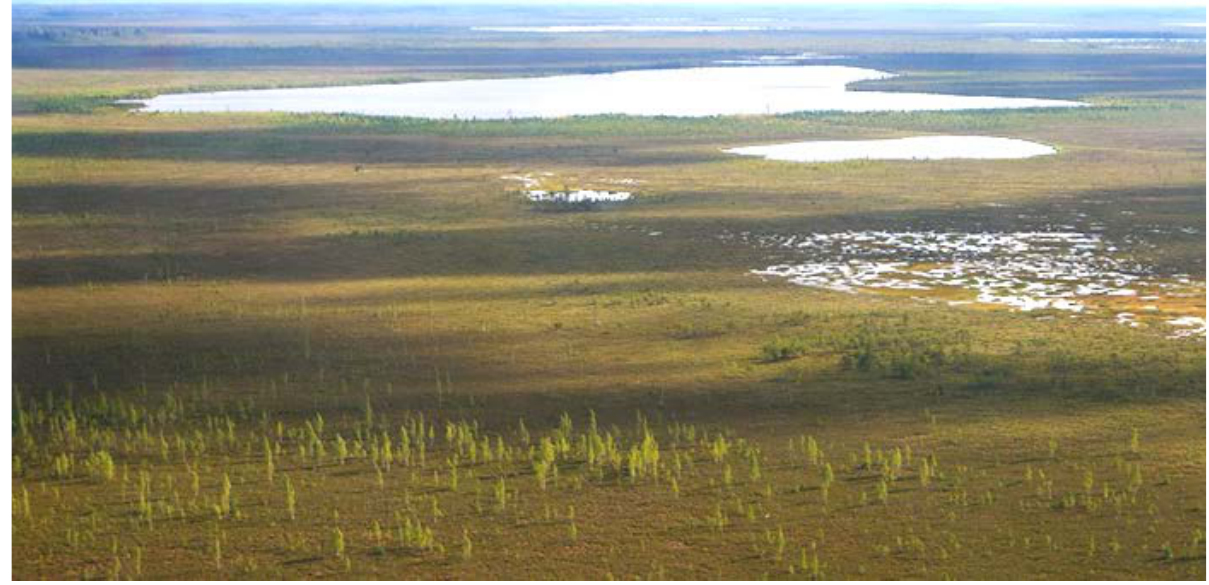
Figure 1. An oblique aerial photograph of the Yelnia peat bog (photo: I.